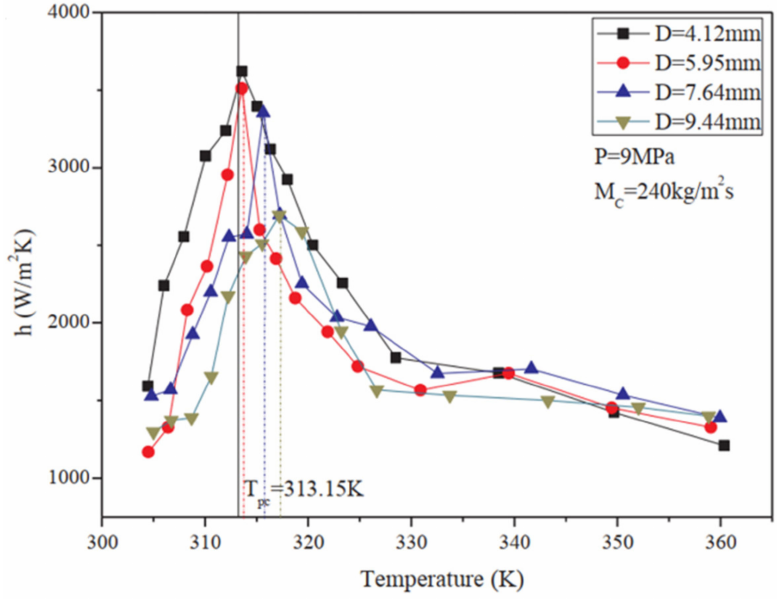
Figure 7. Variation of effective heat transfer with different tube diameters